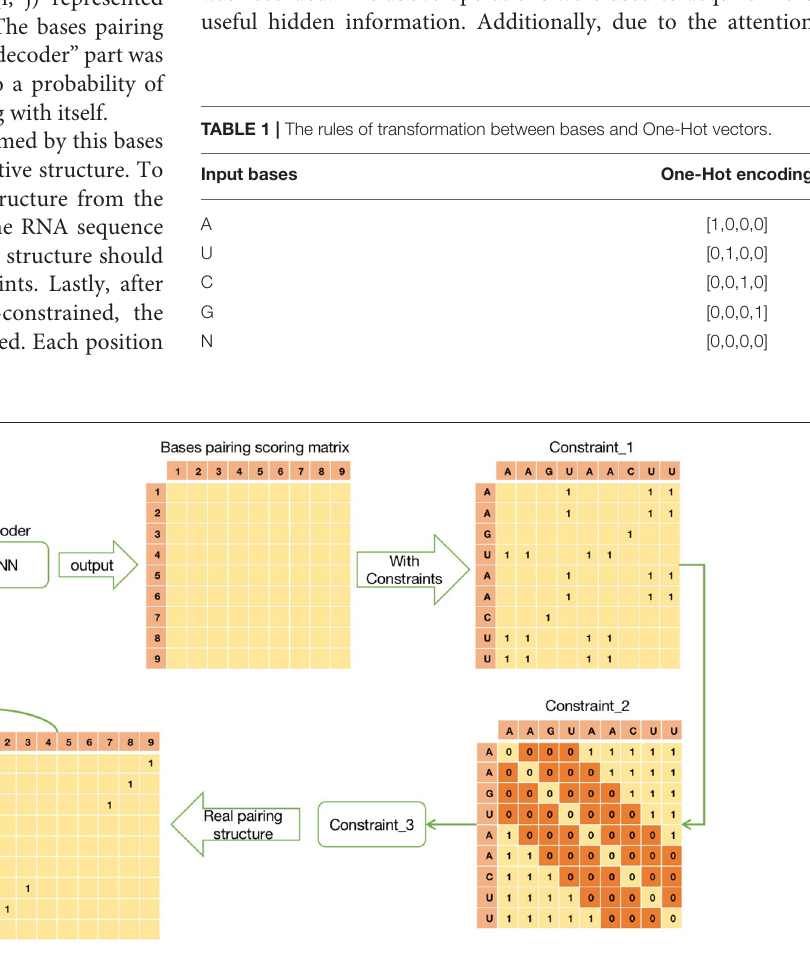
Frontiers in Genetics |